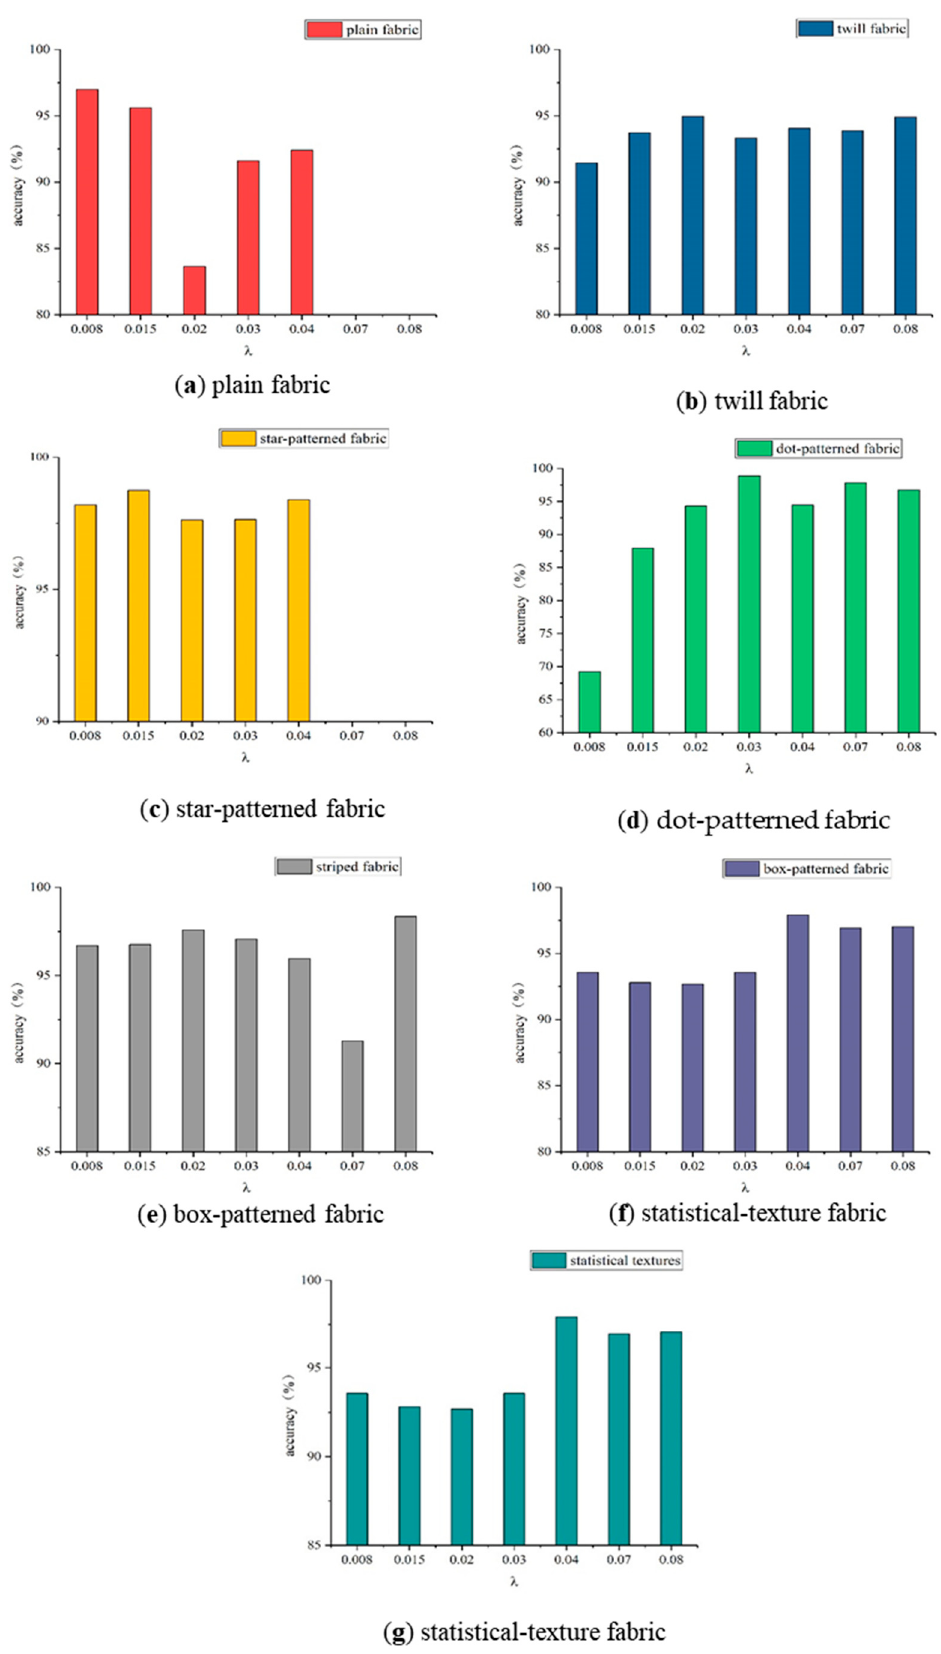
Figure 8. The accuracy bar chart of various fabric types’ detection under the number of different parameters λ .